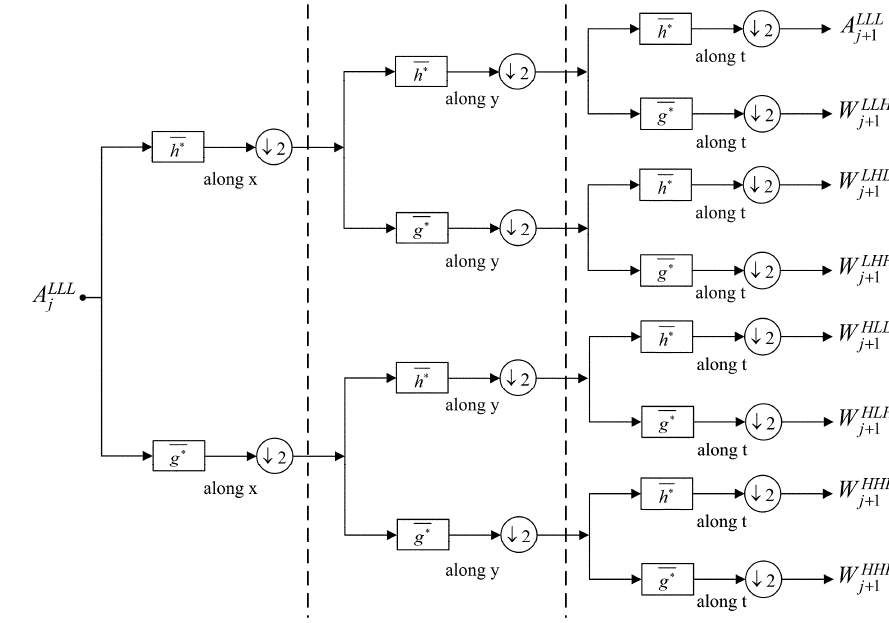
Figure 2. Block diagram of the analysis filter bank of the 3D discrete wavelet transform (DWT).